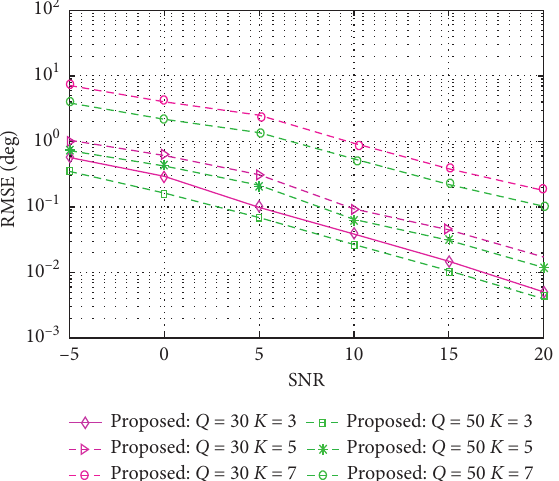
Figure 7: The proposed algorithm estimation performance of varying K against SNR.